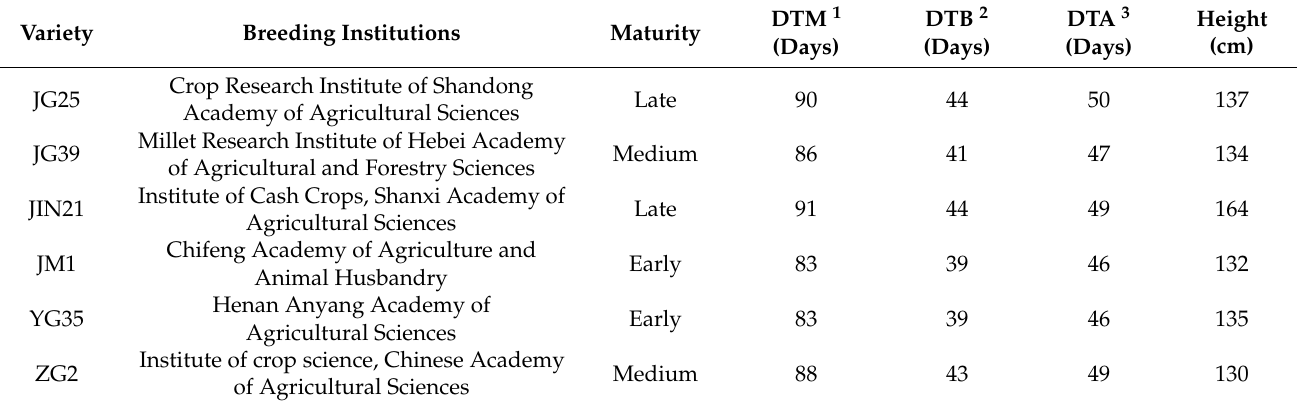
Table 1. Description of the study